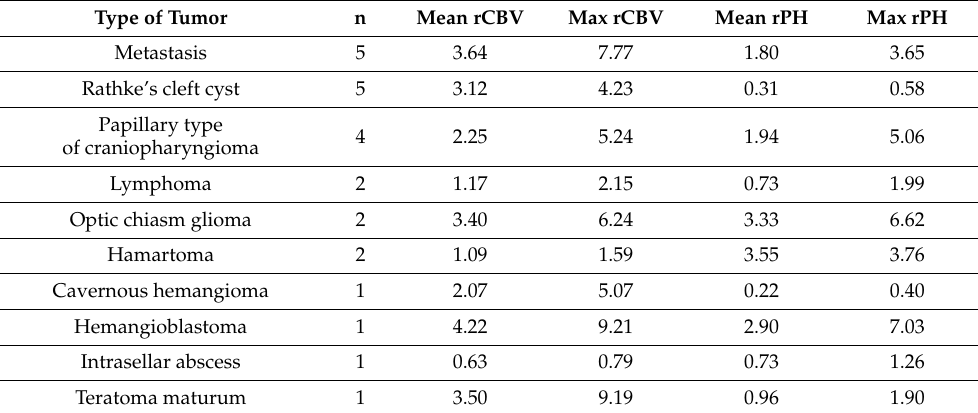
Table 5. Measurements of perfusion parameters of tumors group consisting of ≤ 5 subjects. Type of